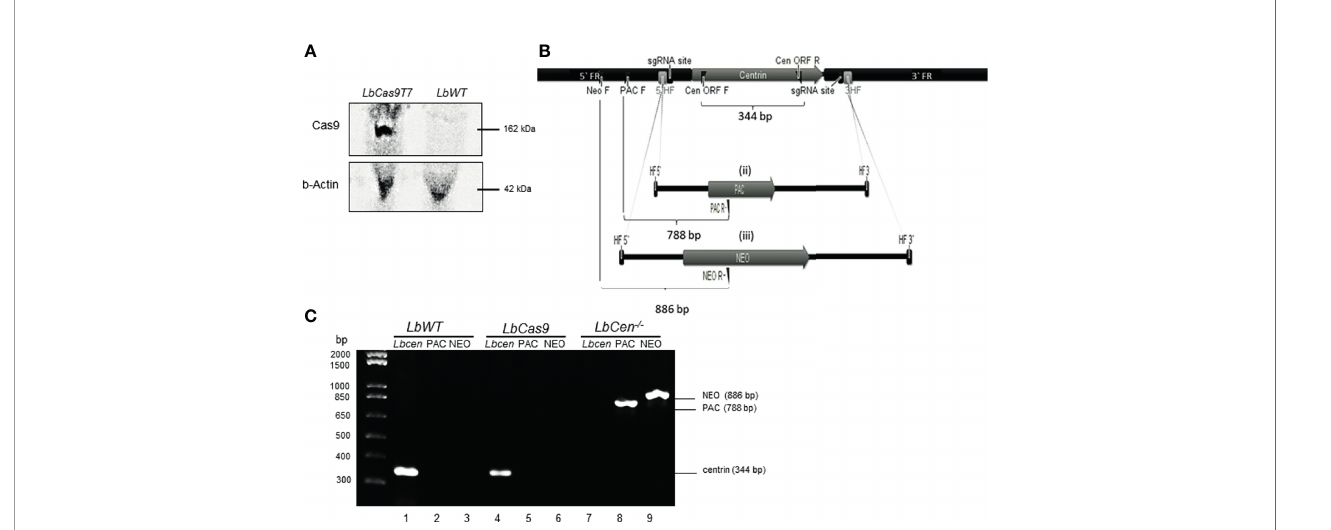
FIGURE 2 | Generation of centrin − / − L. braziliensis. (A) Western blot of whole cell lysates probed with anti-Cas9 antibody and anti-b-Actin. LbWT , parental cell line, LbCas9T7 , L. braziliensis expressing Cas9 and T7. (B) In silico representation of the CRISPR-Cas9 based deletion of the L. braziliensis putative centrin gene (i) centrin genomic locus indicating sgRNA (guide RNA) binding sites at both 5` and 3` UTRs, 3`& 5` HF (homology fl ank) or fl anking regions (30 bp) and primers for the correct integration ( fl ag). PAC and NEO forward primers (PAC F and NEO F), Cen ORF forward and reverse (CEN ORF F and CEN ORF R) diagnostic primers for detection of centrin gene (ampli fi cation of 344 bp fragment). (ii) & (iii) Donor cassettes containing PAC and NEO antibiotics markers, indicating diagnostic reverse primers (PAC R and NEO R and size of expected amplicons for the con fi rmation of correct integration of the cassettes (788 and 886 bp, respectively). (C) PCR analysis of generated cell lines: test for the presence of the Centrin in Lb WT parental line and in LbCas9T7; test for the integration of the PAC and NEO-resistance genes in LbCen − / − . PCR products were analyzed on a 1% agarose gel.